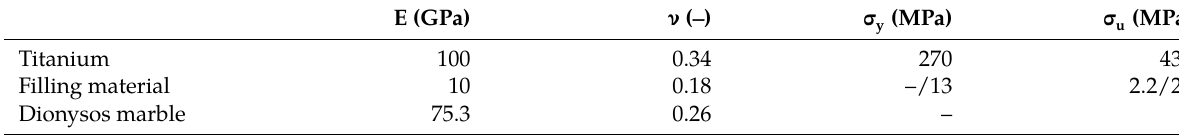
Table 1: The mechanical properties of the three materials used in the numerical model. E (GPa) ν ( – ) σ (MPa) σ (MPa) y u Titanium 100 0.34 270 430 Filling material 10 0.18 – /13 2.2/24 Dionysos marble 75.3 0.26 – – Double values correspond to tension and